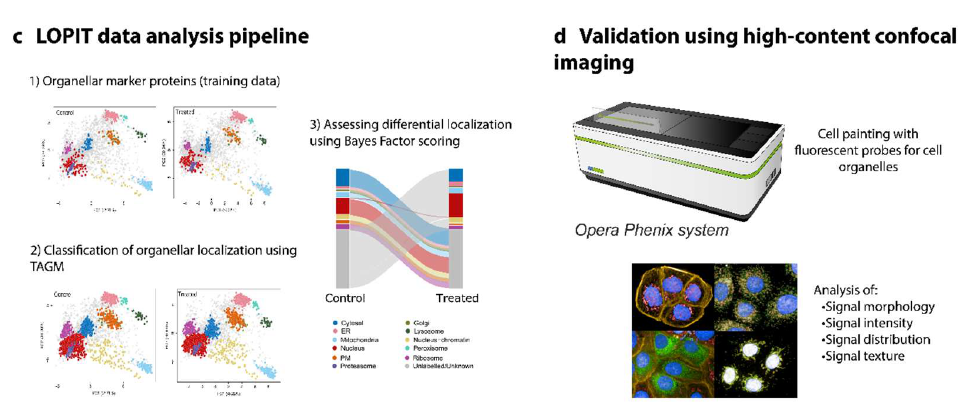
Figure 1. LOPIT-DC workflow applied to F508del-CFTR CFBE41o- cells. ( a ) Mechanism of action of Lumacaftor (VX-809), a drug used to promote the folding and trafficking of F508del-CFTR to the PM. ( b ) Schematic of LOPIT sample and data acquisition. After incubation with either VX-809 or control DMSO, cells were lysed and organelles separated by differential centrifugation into 10 fractions. Following tryptic digestion, the peptide content of each fraction was then labelled with a different isobaric tag (TMT), and fractions pooled together and analyzed by nanoLC-MS/MS. In each peptide MS/MS spectrum, the relative intensity of the TMT reporter ions is associated with the abundance of the corresponding protein in each fraction. ( c ) LOPIT data analysis pipeline. Based on the data from markers of known subcellular localization using multivariate data analysis, the spatial map of the CFBE41o- proteome was produced for each condition. Using SVM classification and Bayes factor scoring, changes in the subcellular localization of proteins following VX-809 treatment are assessed. ( d ) Validation of LOPIT-DC hits using high-content confocal